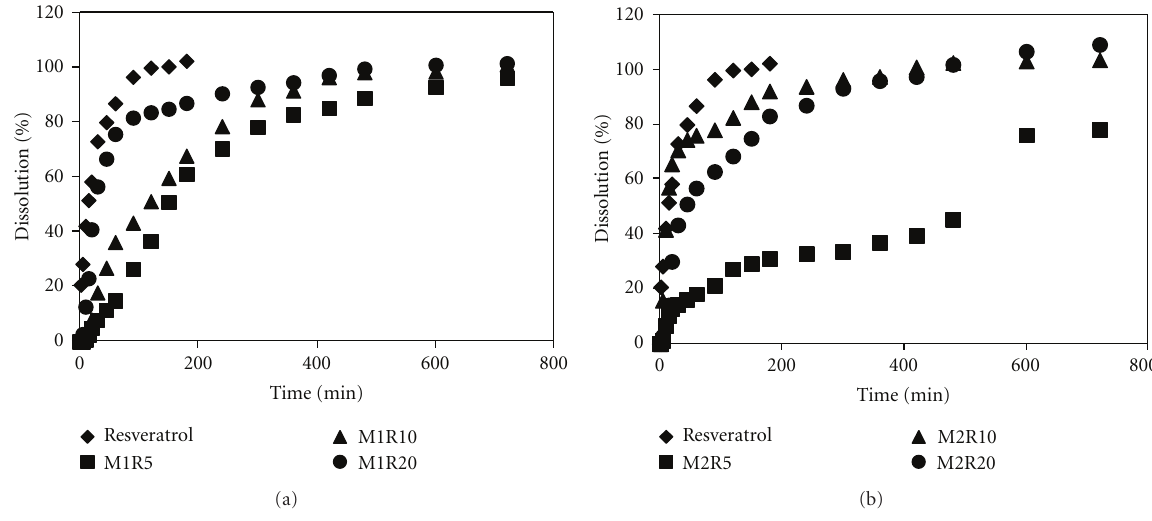
Figure 8: In vitro release profiles of pure drug and resveratrol-loaded PHBV/PCL